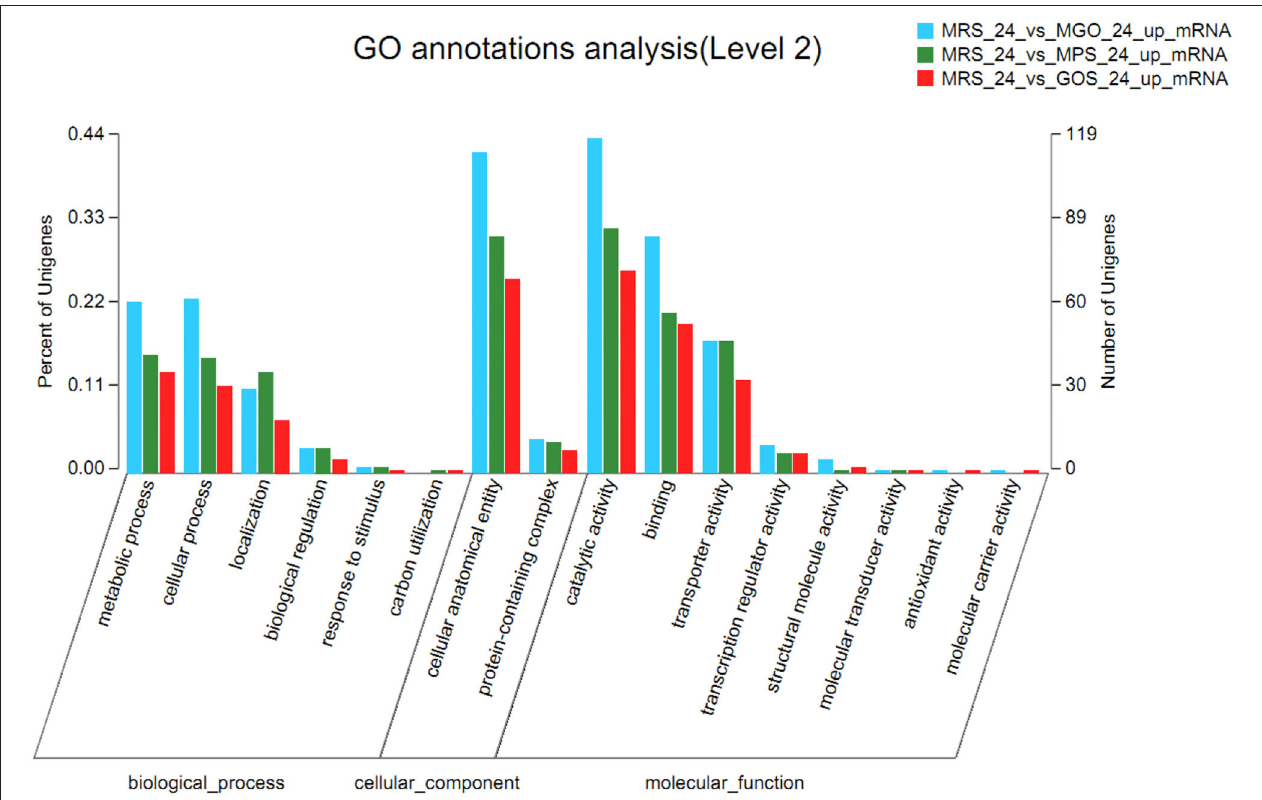
FIGURE 4 | Comparative transcriptomic analysis of LGG cultured with different prebiotics for 24h. Histogram presentation of differentially expressed gene ontology classifications. The results are summarized in three main categories: biological process, cellular component, and molecular function. The left y-axis represents the percentage of unigenes of a specific category within the main category, and the right y-axis represents the number of unigenes of a specific category within the main category. The bar indicates the number of up-regulated